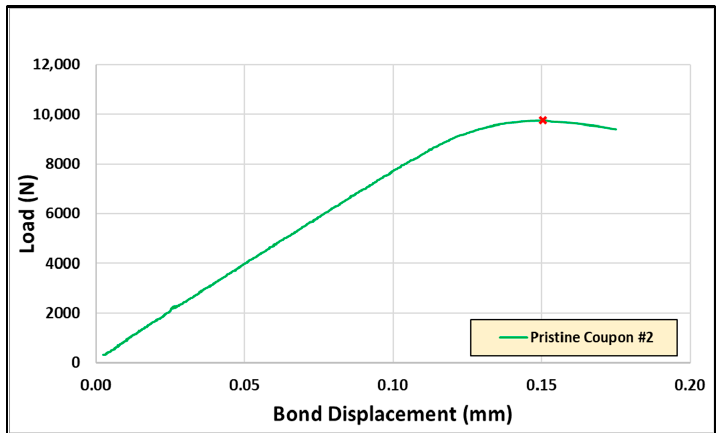
Figure 15. Pristine test coupon #2 load versus displacement (final load increment).